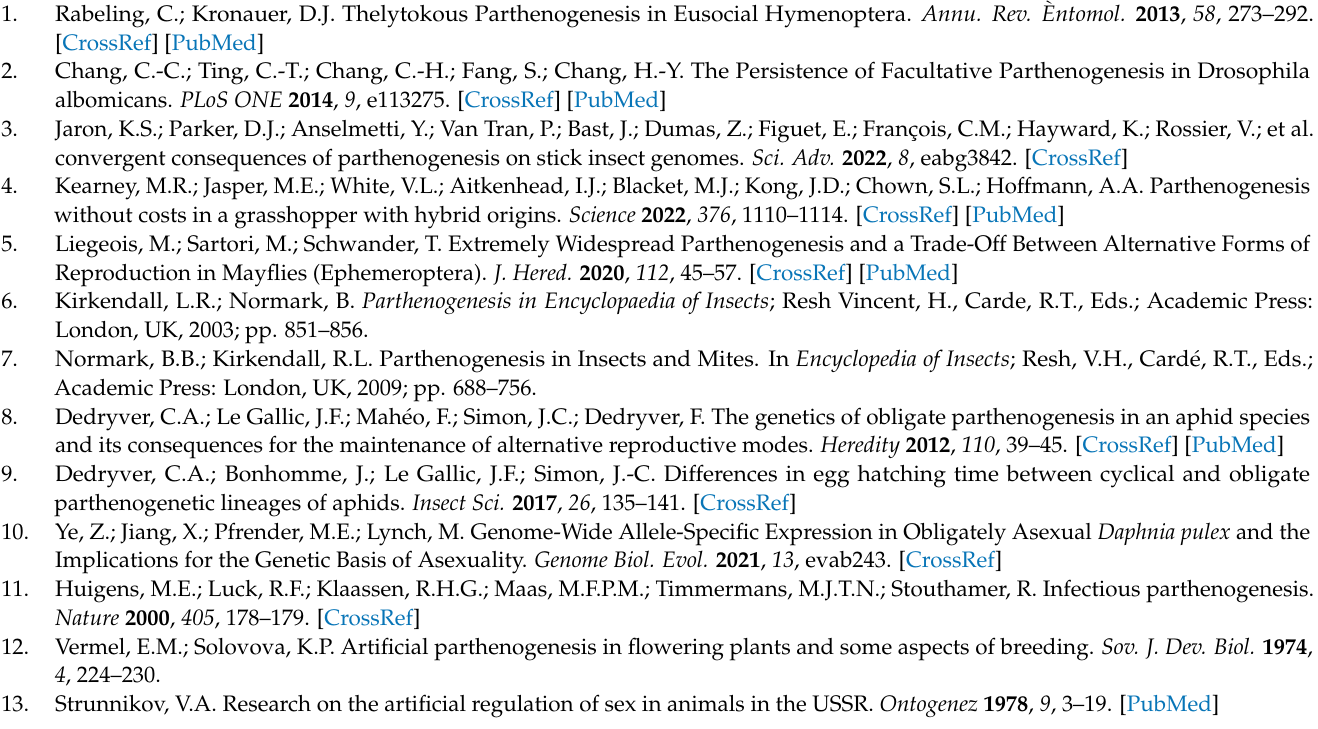
Supplementary Figure S1. The response of oxidative phosphorylation pathway after thermal induc- tion in parthenogenetic line. The red rectangle indicates upregulated proteins and the green one indicates downregulated proteins; Supplementary Figure S2. The response of citrate cycle pathway after thermal induction in parthenogenetic line; the red rectangle indicates upregulated proteins and the green one indicates downregulated proteins. Supplementary Figure S3. The response of Hippo signaling pathway after thermal induction in parthenogenetic line. The red rectangle indicates upregulated proteins and the green one indicates downregulated proteins; Supplementary Figure S4. The response of ECM–receptor interaction pathway after thermal induction in parthenogenetic line. The red rectangle indicates upregulated proteins and the green one indicates downregulated